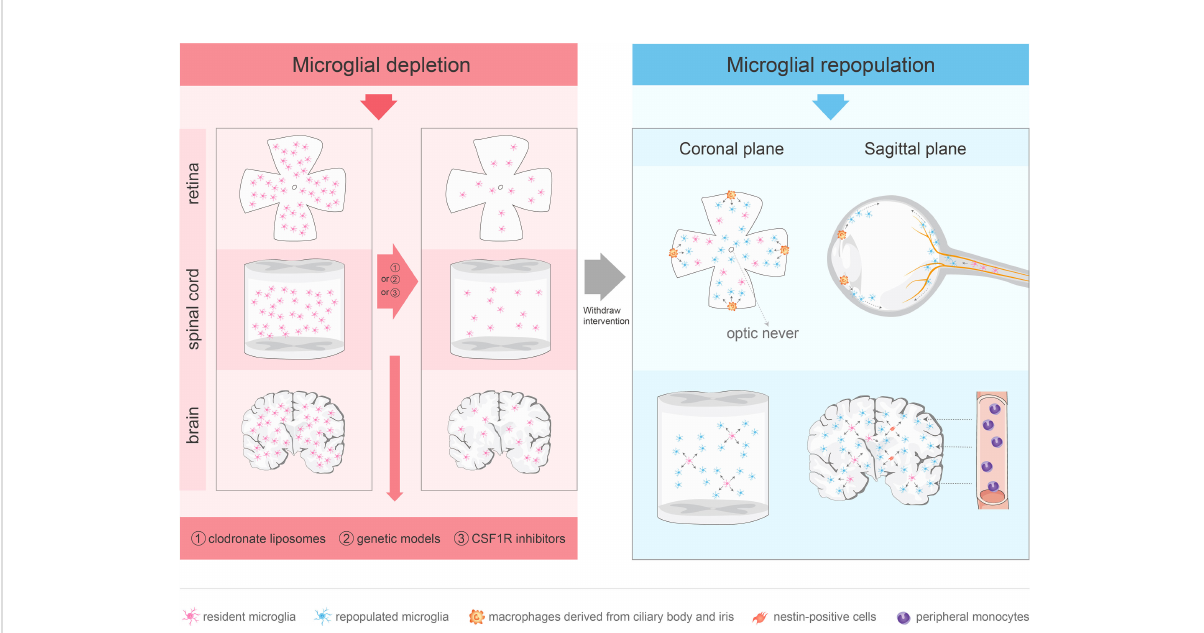
FIGURE 1 Approaches for microglial depletion and multiple sources of microglial repopulation. Robust methods for depleting microglia in vivo include clodronate liposomes, genetic models and CSF1R inhibitors. These methods deplete microglia in the CNS effectively. After withdraw the intervention, microglia repopulate and return to normal levels in 1 – 2 weeks. The repopulated microglia in the retina are not derived from nestin-positive progenitor cells. The repopulated microglia in the center arise from the residual microglia in the optic nerve, while the periphery-emerging microglia are from macrophages in the ciliary body/iris. Spinal microglia can reproduce rapidly after removal, which is mainly driven by the process of self-renewal. Microglia in the brain may repopulate in one of three ways: stimulation of microglia progenitor cells that express nestin, proliferation of residual microglia, or in fi ltration of peripheral mononuclear